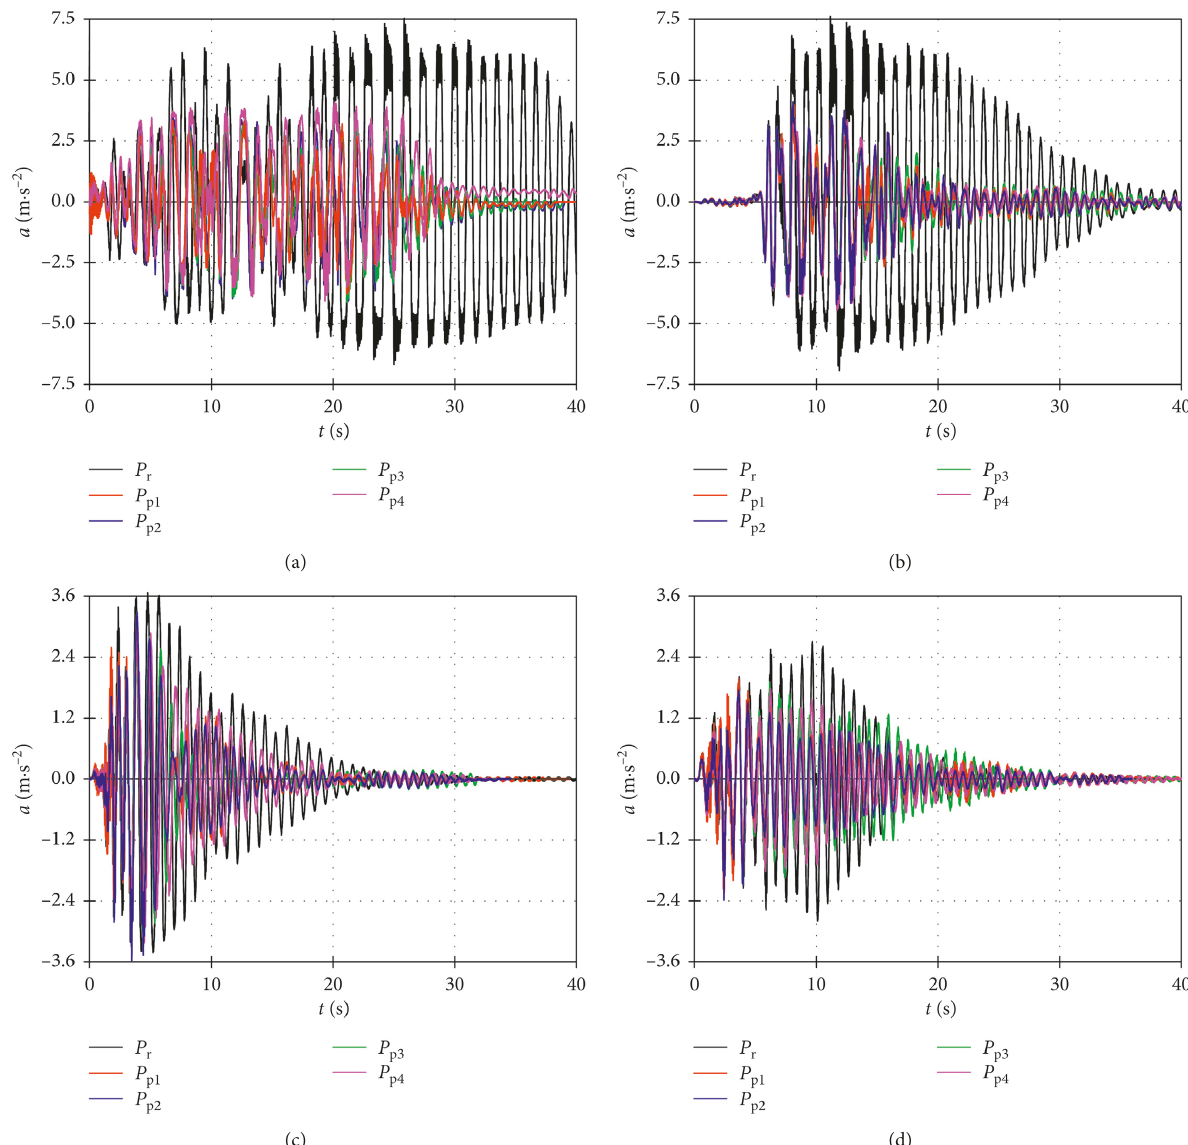
Figure 15: Horizontal acceleration of the mass center at the column top (a) for MSSB. (a) Artificial accelerogram (AA). (b) Accelerogram Petrovac (AP). (c) Accelerogram Ston (AS). (d) Accelerogram B. Luka